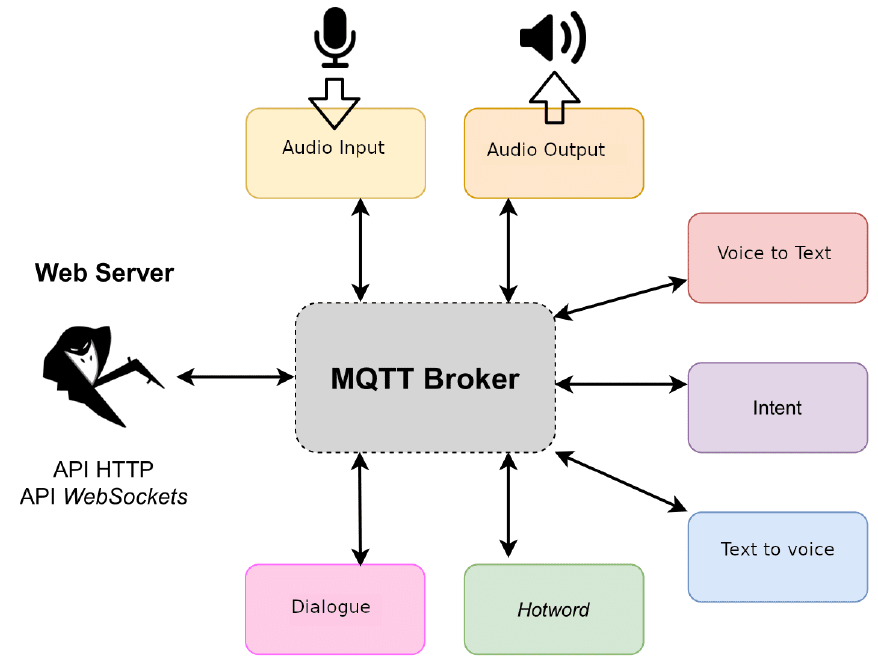
Figure 14. Services provided by Rhasspy for the voice